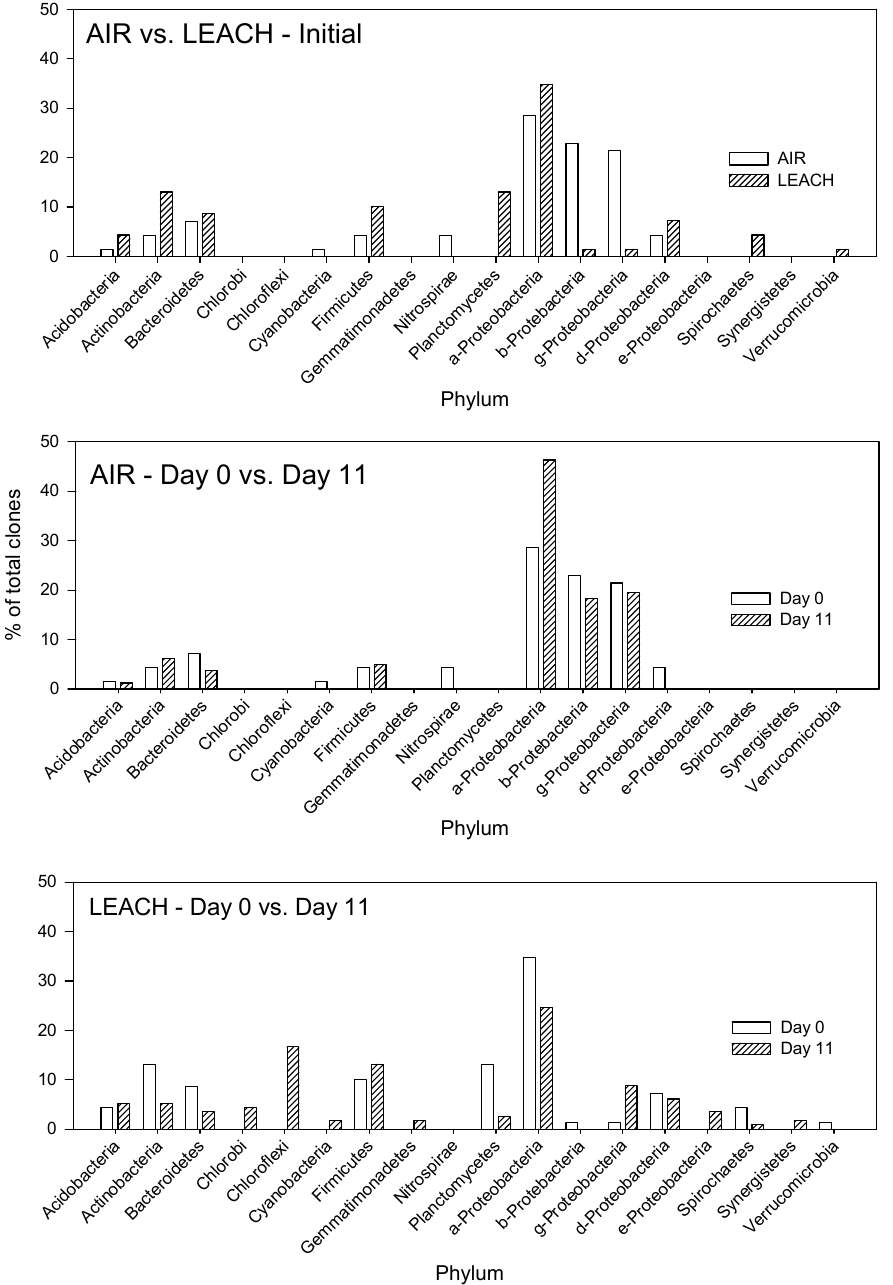
Figure 3. Relative distribution of clones in different phyla in soil from intermittently aerated (AIR) and unaerated (LEACH) leachfield mesocosms before (Day 0) and after (Day 11) dosing with